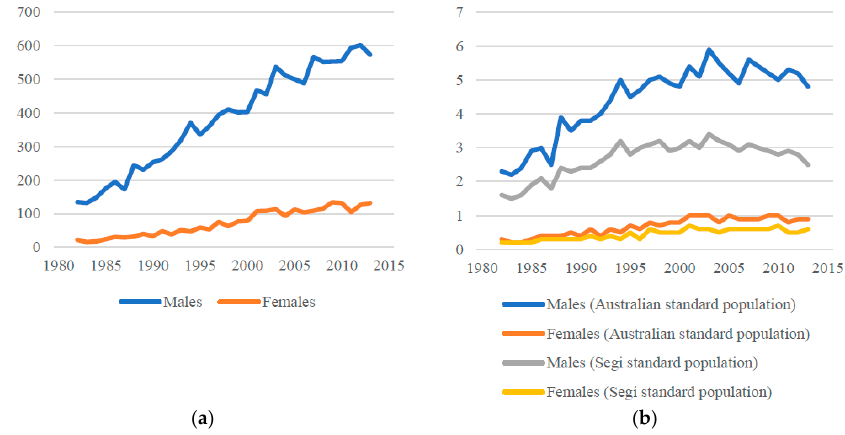
Figure 1. Incidence of malignant mesothelioma, Australia, 1982–2013, using data published by the Australian Institute of Health and Welfare. ( a ) Incident cases of malignant mesothelioma; ( b ) Age-standardised incidence rates per 100,000 of malignant mesothelioma using Australian and Segi world standard populations.